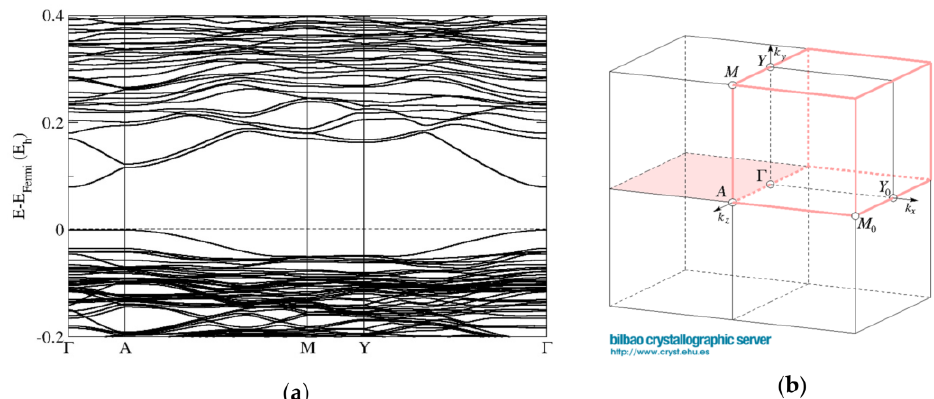
Figure 9. Band structures ( a ) of the wurtzite ZnO 0.813 S 0.187 supercell model computed using the PBE0 functional with fully relaxed and distorted monoclinic (Cm) symmetry and ( b ) corresponding directions in the Brillouin zone (https://www.cryst.ehu.es/cryst/get_kvec.html, accessed on 6 November 2022).